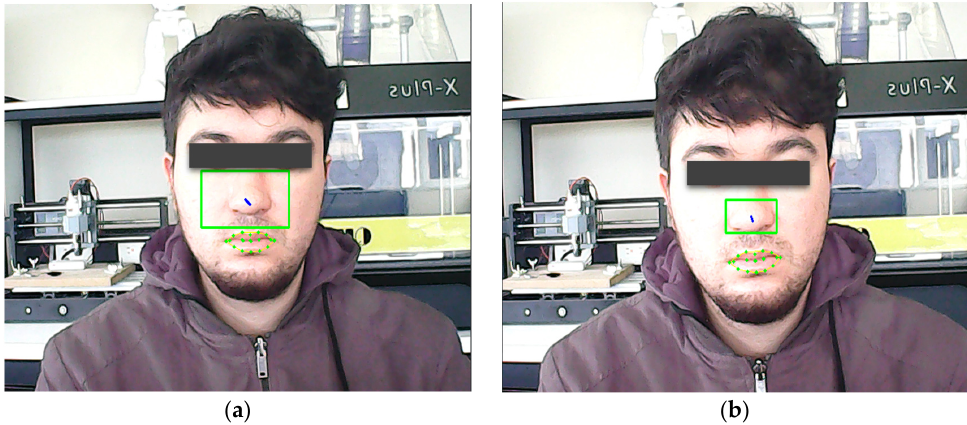
Figure 7. Green boundary box size comparison. ( a ) Rectangle of size 65 × 35 pixels/frame processed; ( b ) rectangle of size 35 × 20 pixels/frame processed.